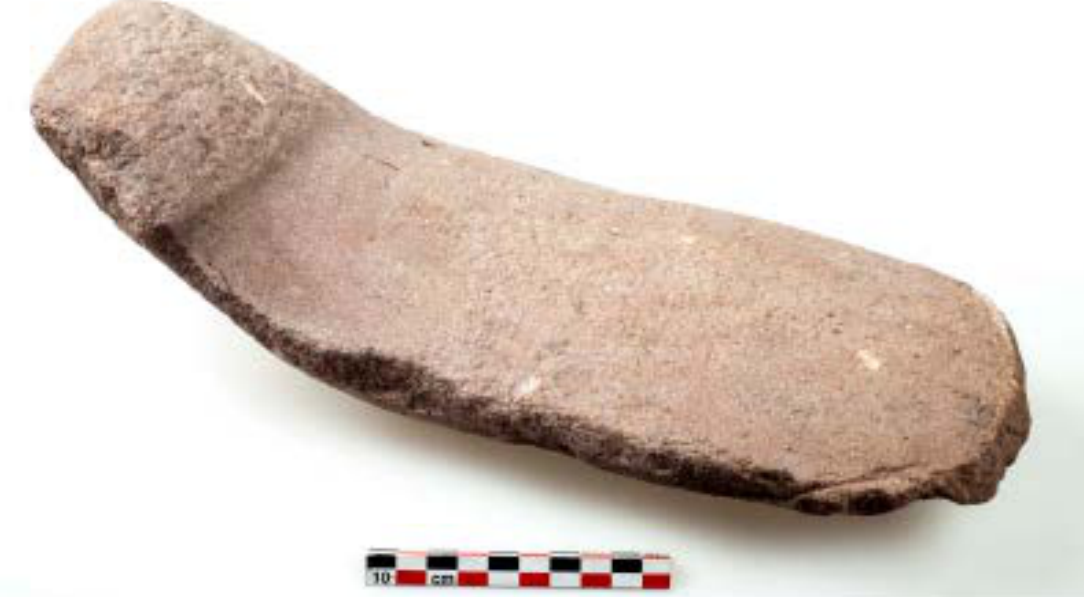
Figure 4. Grinding surface of an overlapping upper stone quern RLT-331-6 (photo: Fr. Schneikert,